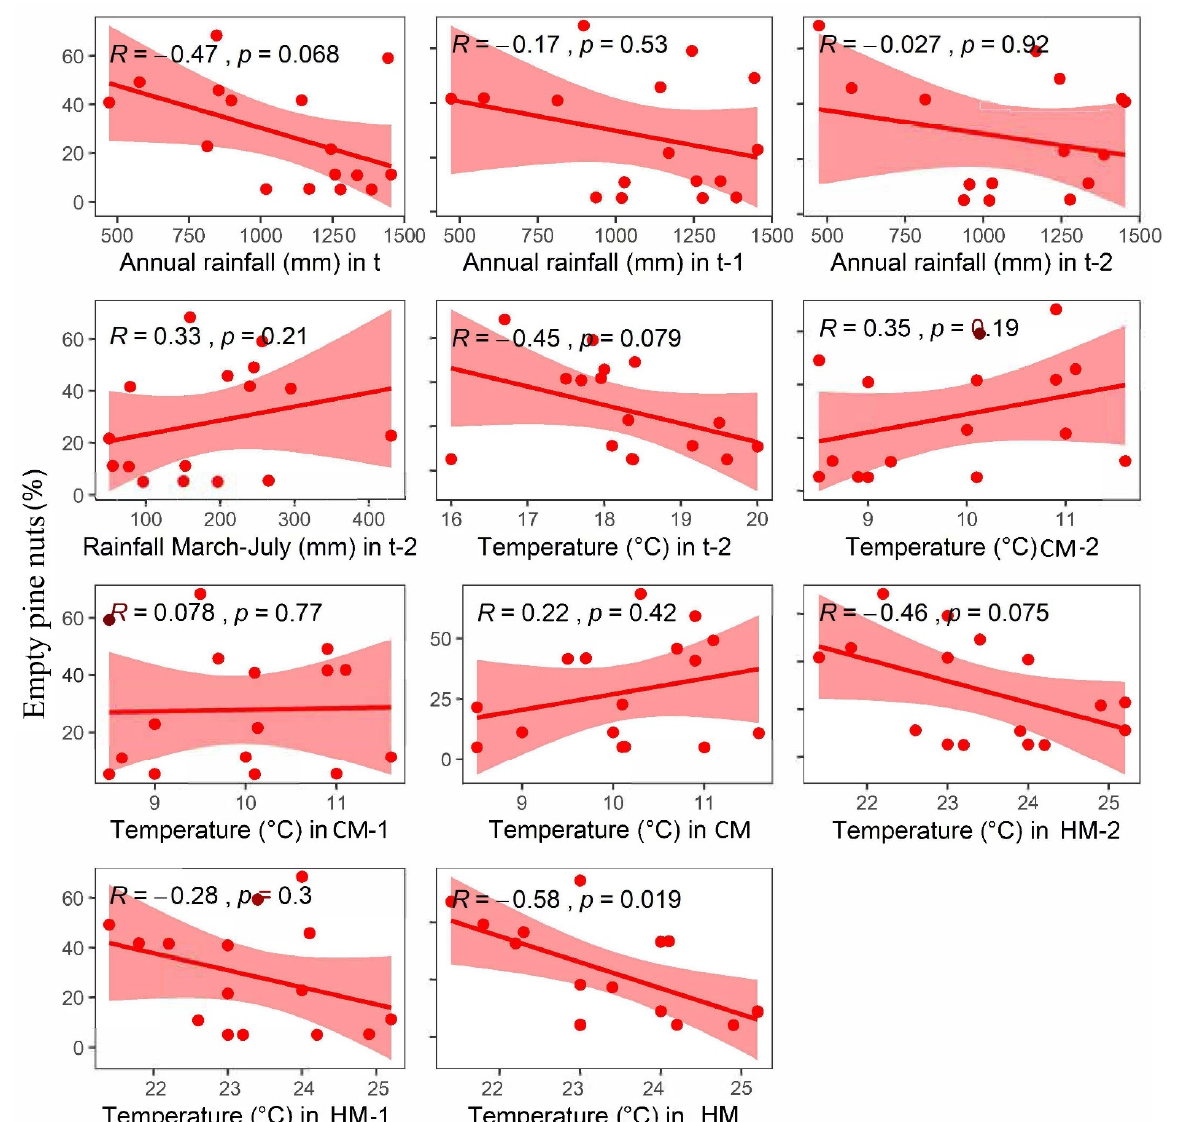
Figure 5 . Summary of Pearson correlation between the percentage of empty seeds and climatic